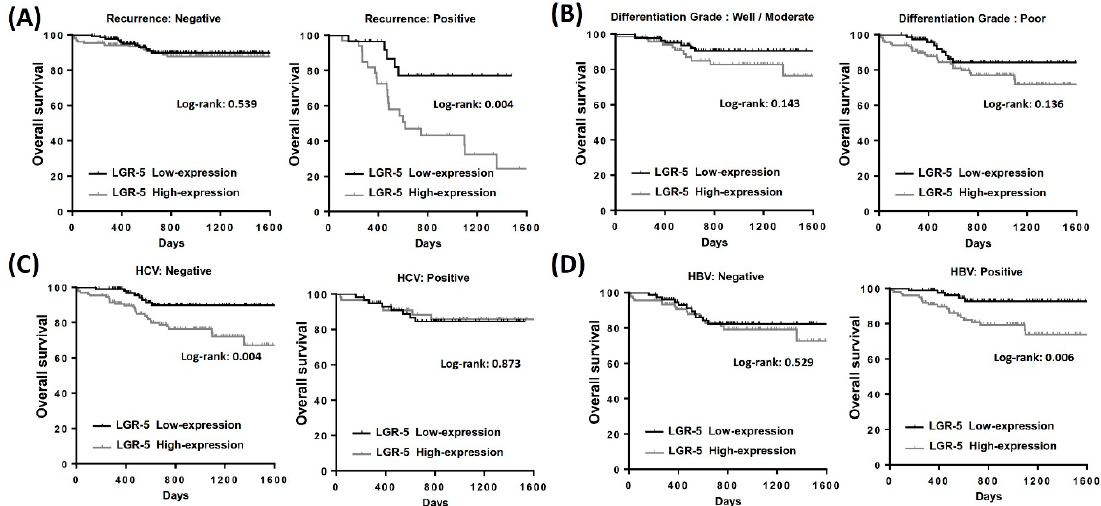
Figure 3. Kaplan–Meier analysis of LGR-5 expression in subgroup analysis in total patients with HCC. ( A ) The overall survival rate in recurrence group and non-recurrence group. ( B ) The overall survival rate in well / moderate di ff erentiation grade group and poor di ff erentiation grade group. ( C ) The overall survival rate in hepatitis C virus infection group and non-hepatitis-C-virus-infected group. ( D ) The overall survival rate in hepatitis B virus infection group and non-hepatitis-B-virus-infected group.